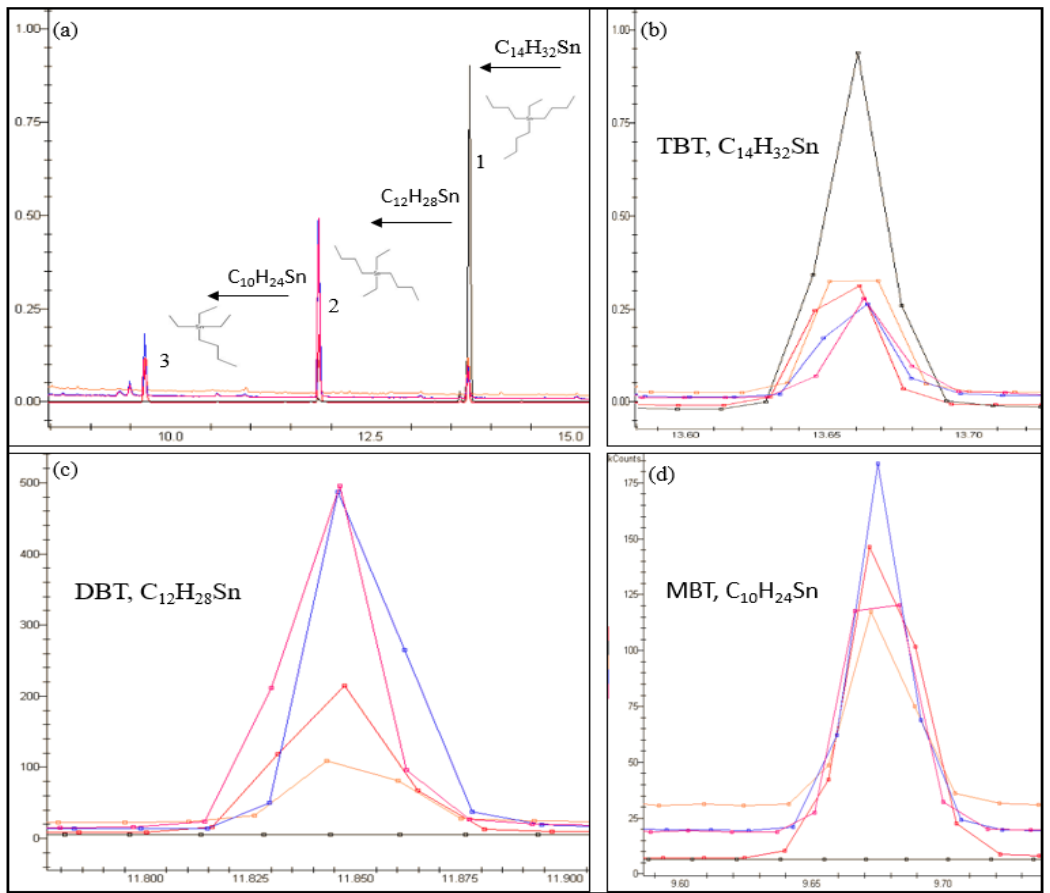
Figure 4. An overlay of multiple chromatograms in selected ion monitoring (SIM) (149, 179, 207, 235, 263, 291 m / z ) (detector response, K count ( y -axis) against retention time minutes ( x -axis)), showing sediment samples analyzed from the microcosm inoculated with C22 on day 0 (black), 30 (orange), 60 (red), 90 (blue) and 120 (pink). Image ( a , b ) demonstrates the microbes (C22) ability to degrade TBT (peak 1) to the less toxic species DBT (peak 2) by a sequential loss of an alkyl group and further to MBT peak (3). Images ( c , d ) emphasizes on the formation of DBT and MBT over the 120 day period from the overlaid chromatograms.